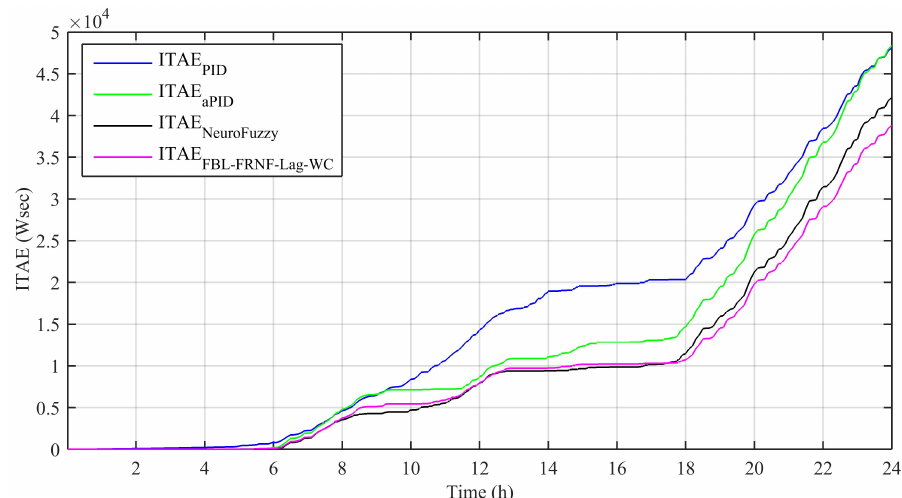
Figure 11. Integral time-weighted absolute error (ITAE) evolution.